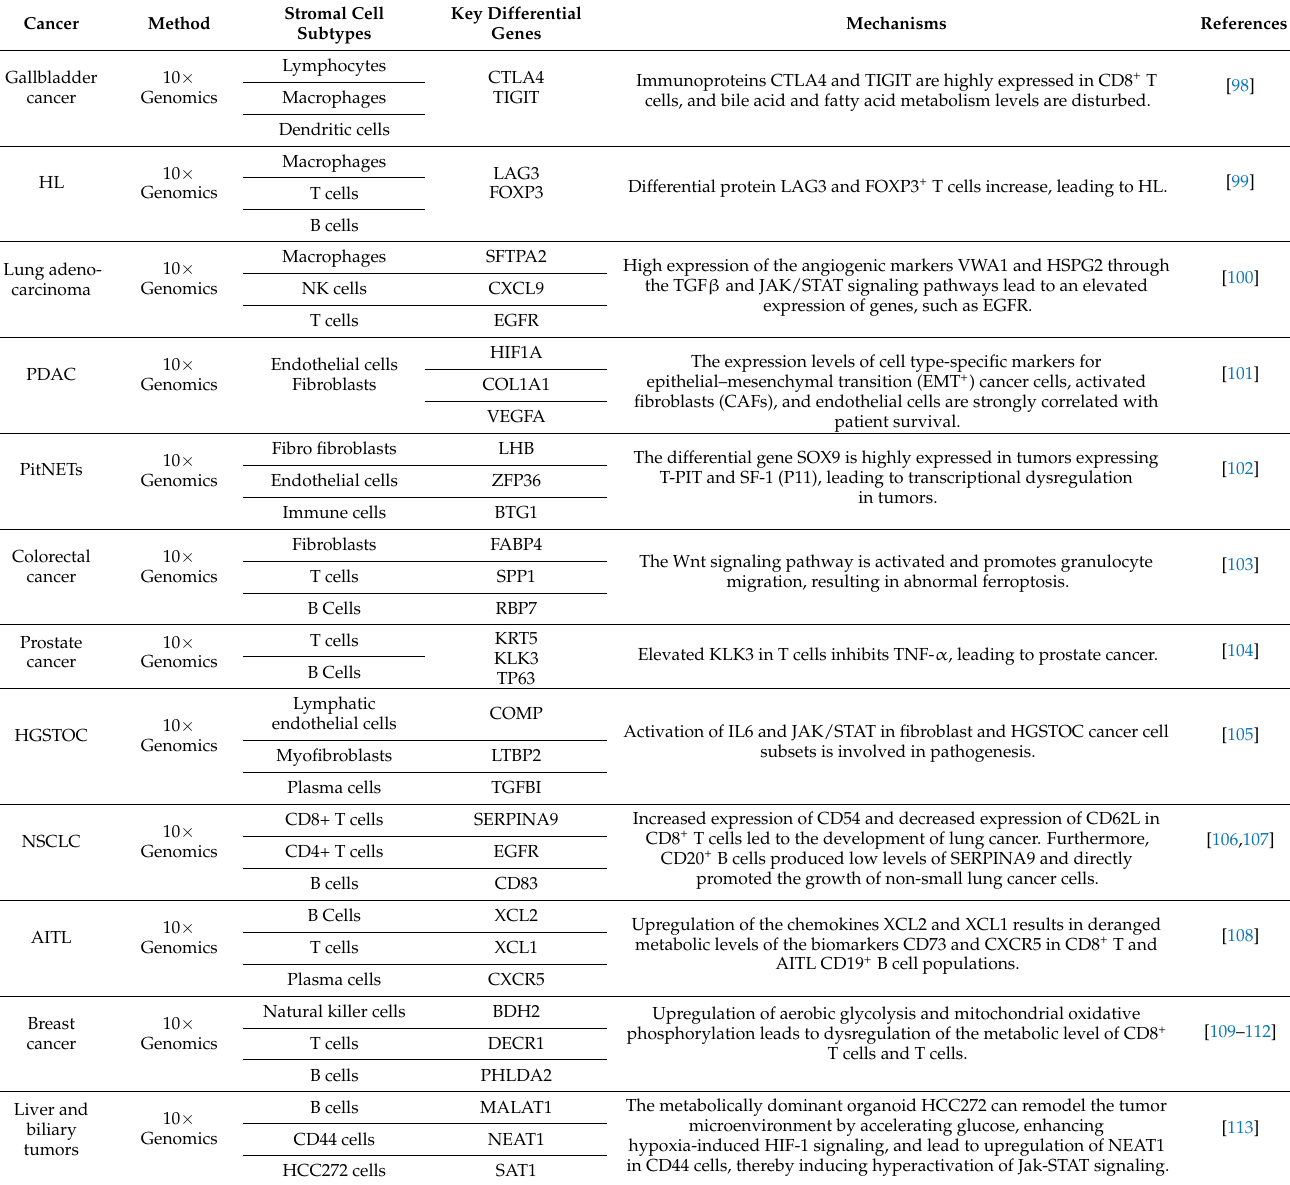
Table 3. Latest applications of scRNA-Seq in cancer